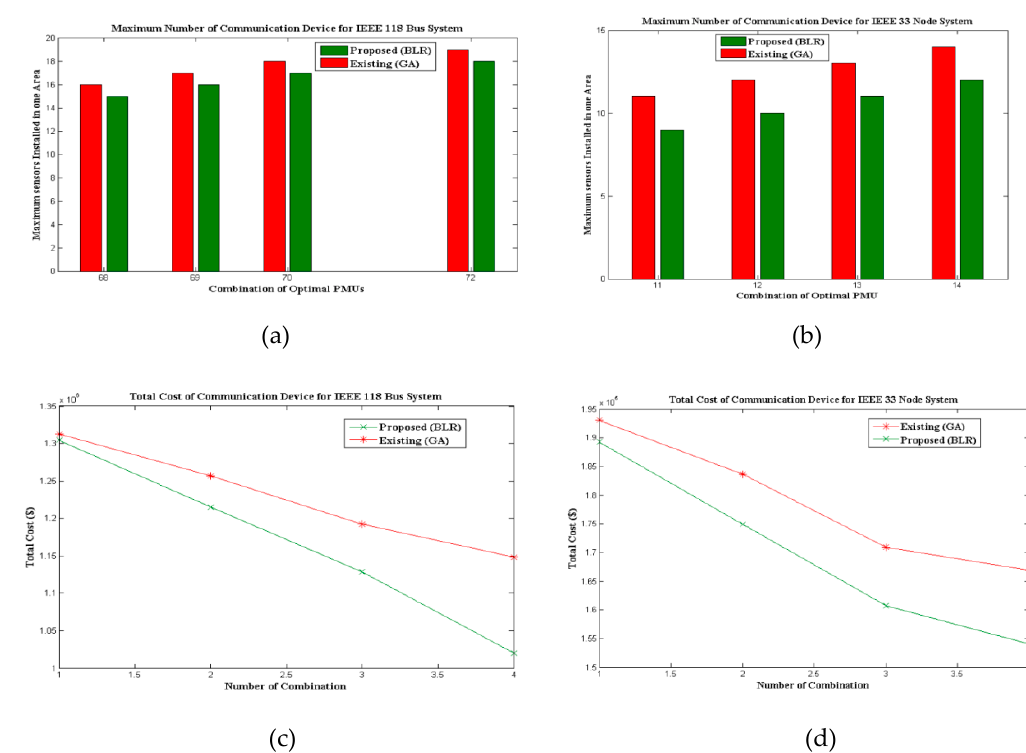
Figure 5. Concentrated installation and cost of communication devices for IEEE 118 bus and IEEE 33 node systems.